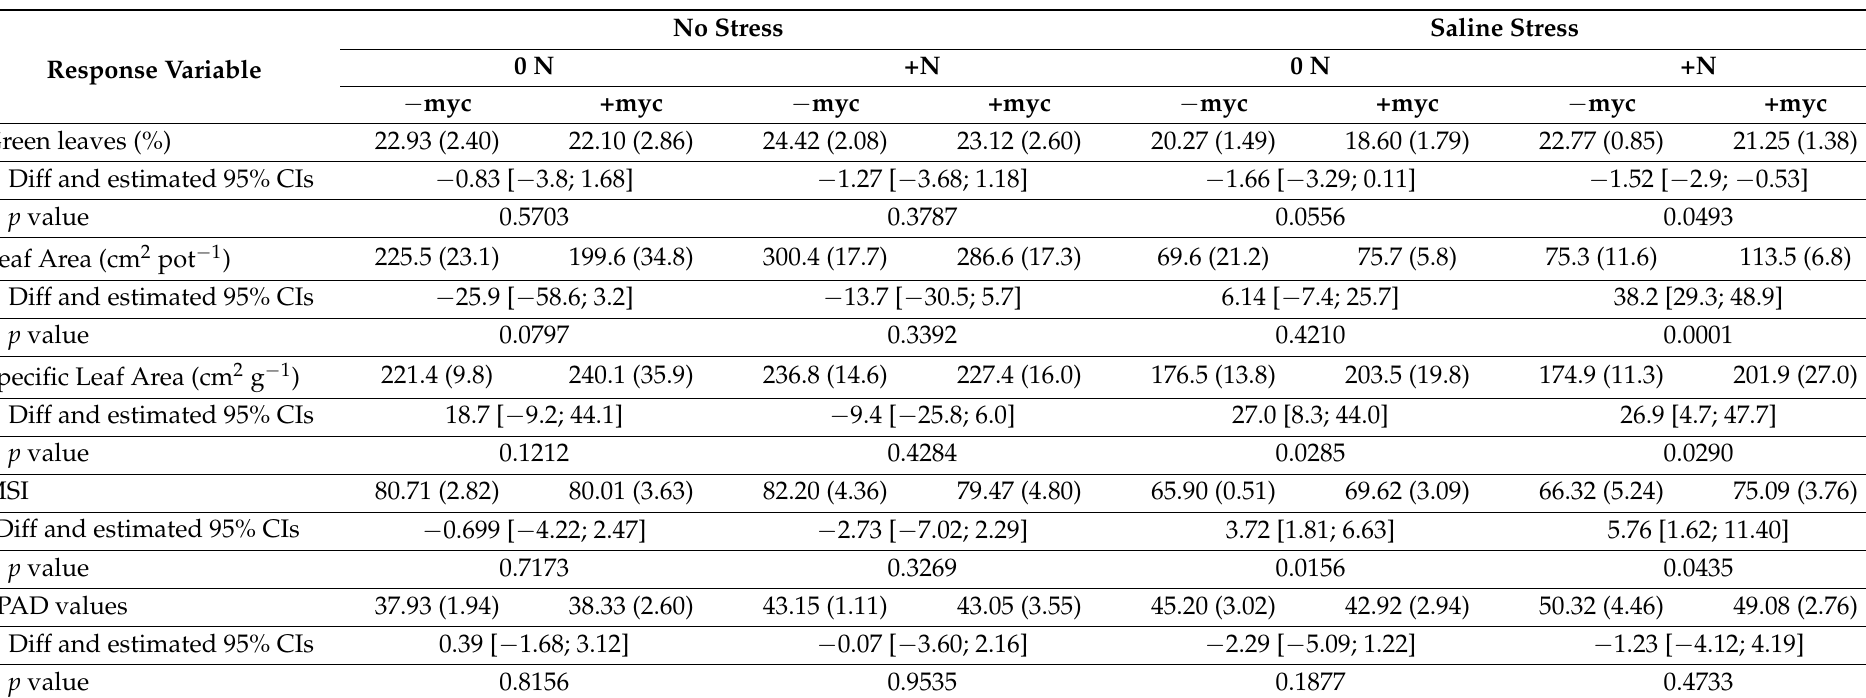
Table 1. Percentage of green leaves on the total biomass, leaf area, specific leaf area, Membrane Stability Index (MSI), and SPAD values to varying